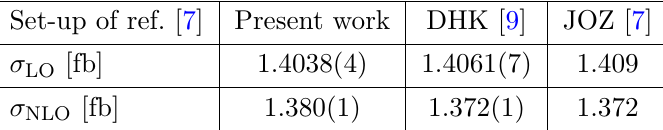
Table 5. Comparison of (cid:12)ducial cross sections at LO [order